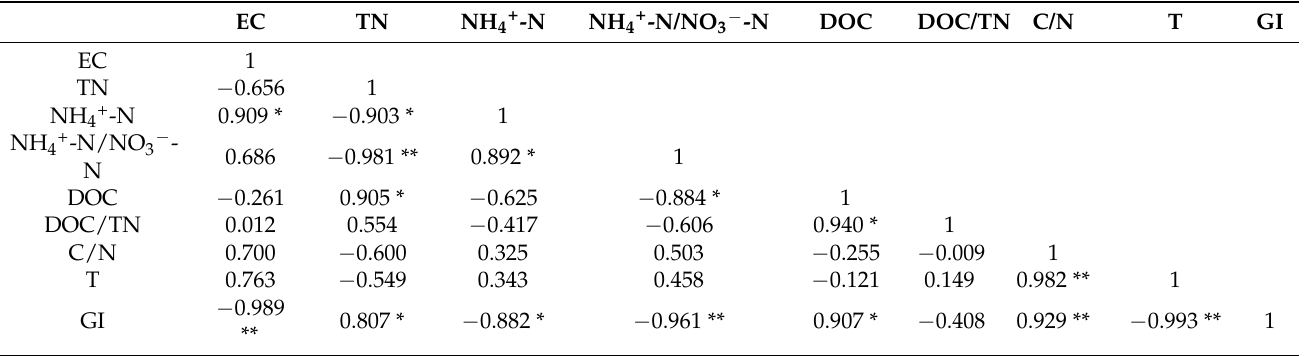
Table 4. Correlation analysis of compost maturity evaluation indexes.